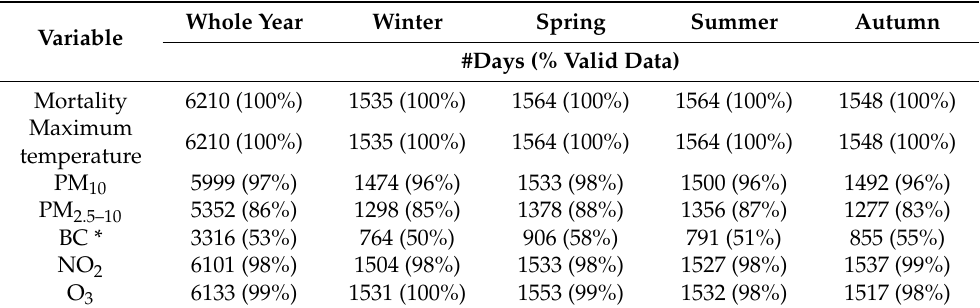
Table A1. Numbers and percentage of days with valid data for the measured variables during the period from 2000 to 2016 divided into whole year and four different seasons. Mortality is indicated